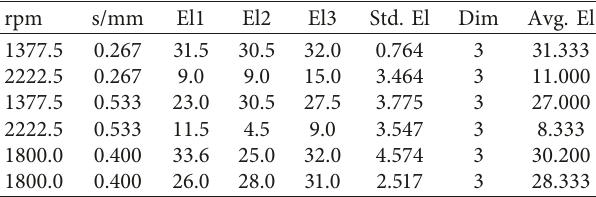
Table 8: Elongation experimental